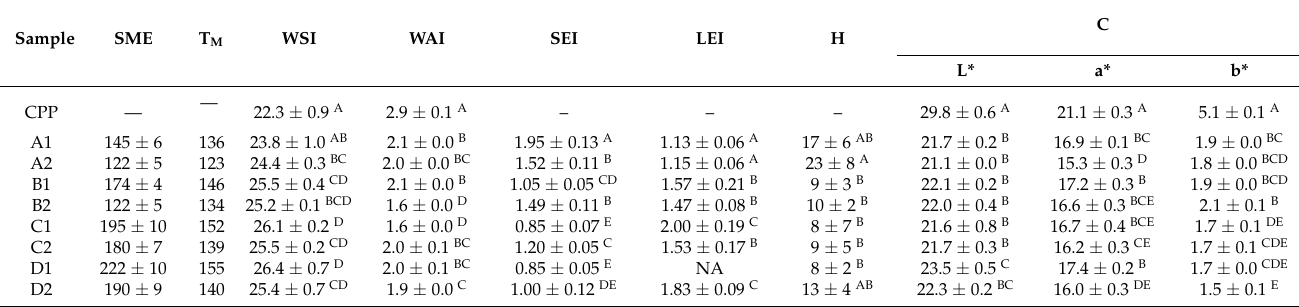
Table 9. Techno-functional and sensory properties of chokeberry pomace powder (CPP) and samples after extrusion processing at water contents of 13% (A1, B1, and D1) and 23% (D2), respectively. SME, specific mechanical energy (Whkg − 1 ); T M , material temperature ( ◦ C); WSI, water solubility index; WAI, water absorption index; SEI, sectional expansion index; LEI, longitudinal expansion index; H, hardness (Nm − 2 ); C, color (L* lightness, a* red/green value, and b* blue/yellow value).